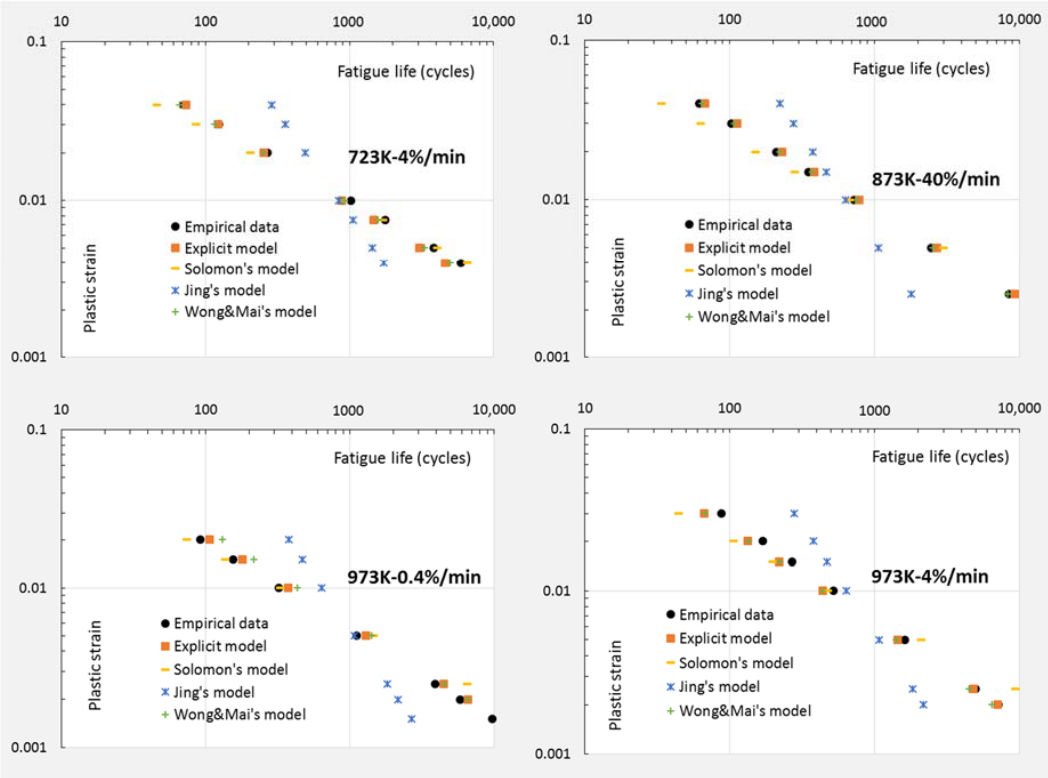
Figure 10. Empirical data for stainless steel 316, and predicted life given by the explicit model, Solomon’s model, Jing’s models, and Wong & Mai’s model.